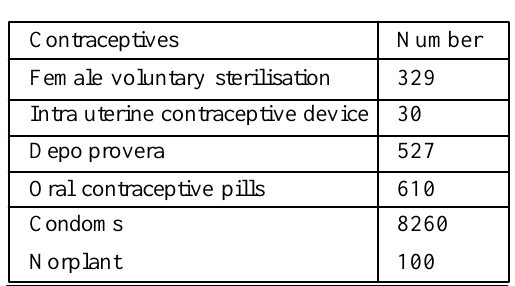
Table 7, showing different types of contraceptives accepted during May 1996 to April